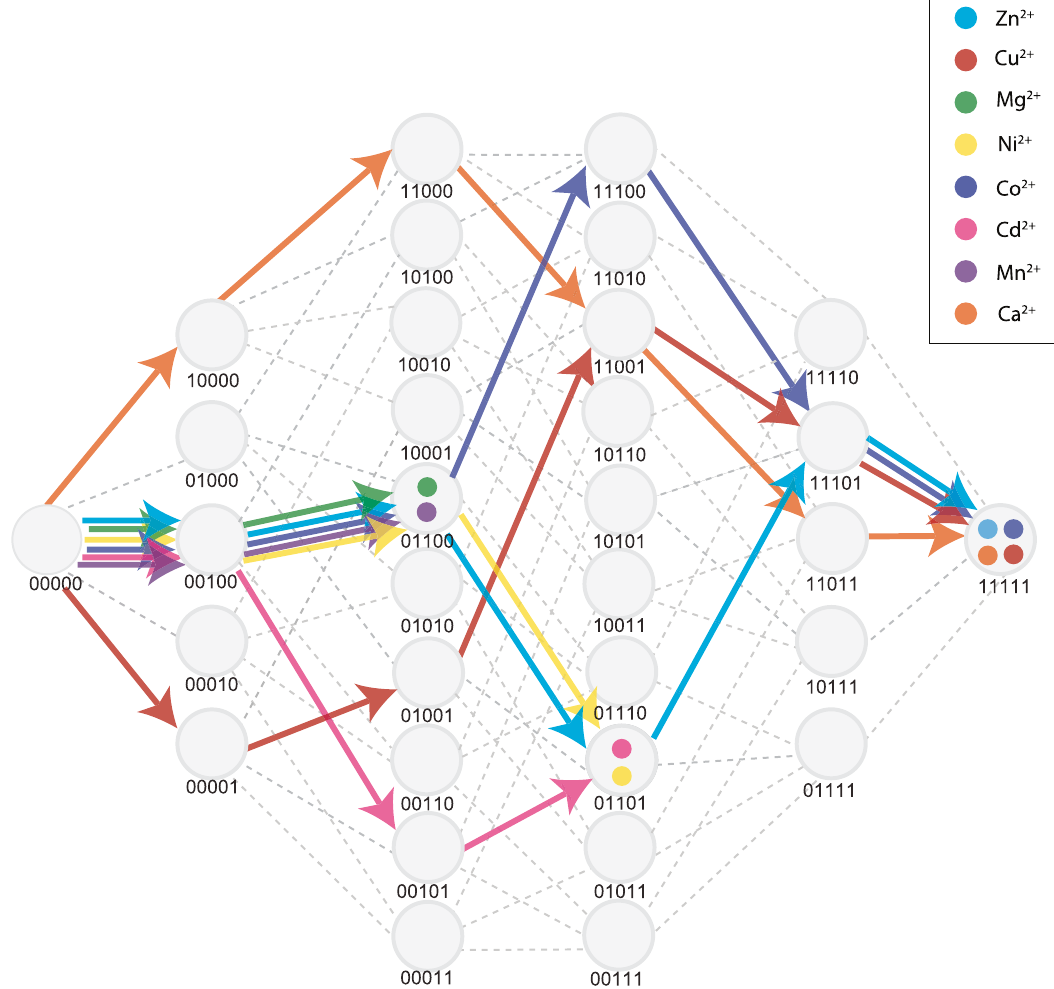
Fig. 6 Change in functional impact of substitutions along adaptive trajectories. The impact of substitutions as they are accumulated along the projected adaptive trajectory in each metal environment. Colored dots indicate the corresponding metal environment ’ s “ end point ” for the projected trajectory beginning at the ancestral DHCH genotype. Genotypes are labeled using a binary system, with “ 0 ” indicating the residue being in the ancestral state and “ 1 ” indicating the residue being in the derived state and are ordered according to the order of the residues in the enzyme sequence (e.g., the fi rst number indicates the state of position 72, the second the state of position 193, the third the state of position 258 and so